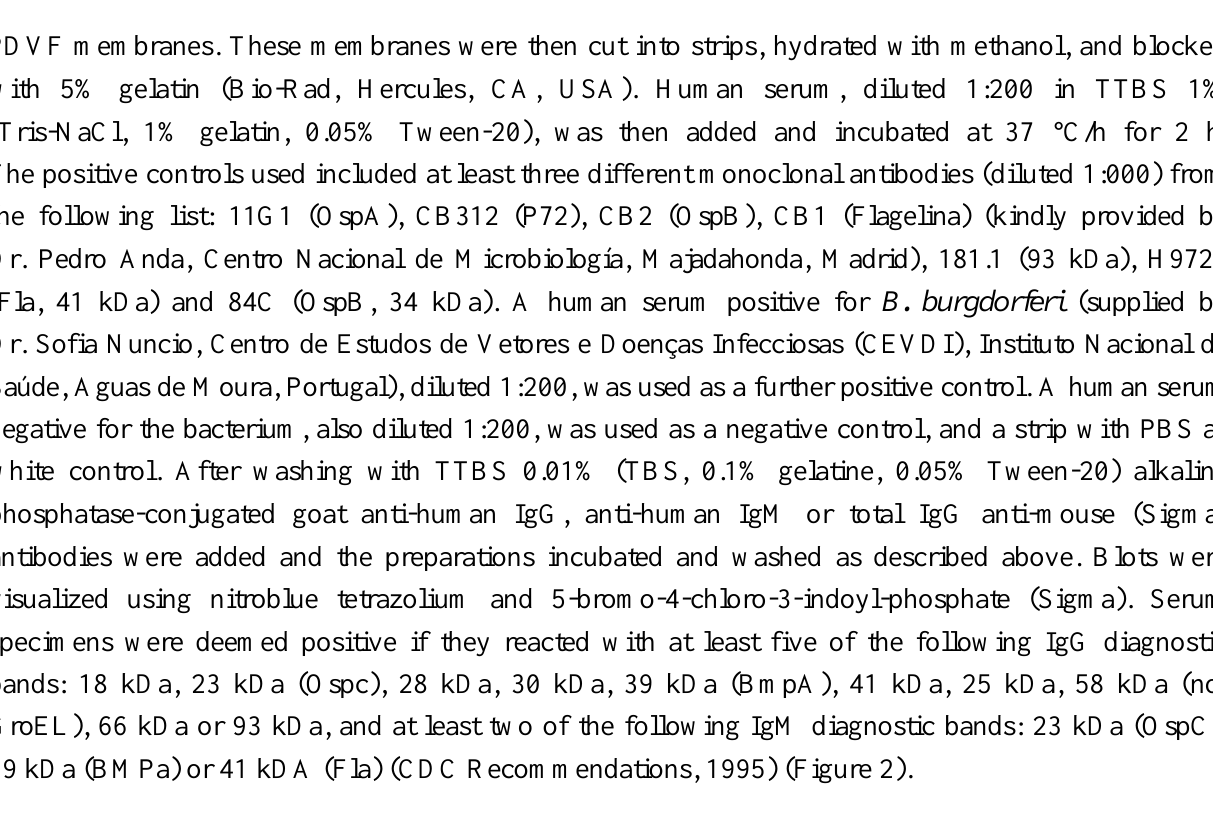
Figure 2. Western blotting of B. burgdorferi . A: MAb CB312 ; B: MAb H9724 ; C: MAb 84C; D and E: Sera positive patient for IgM (second and third samples respectively); F: Positive control; G: Negative control; H: white control (PBS); MW: molecular weight